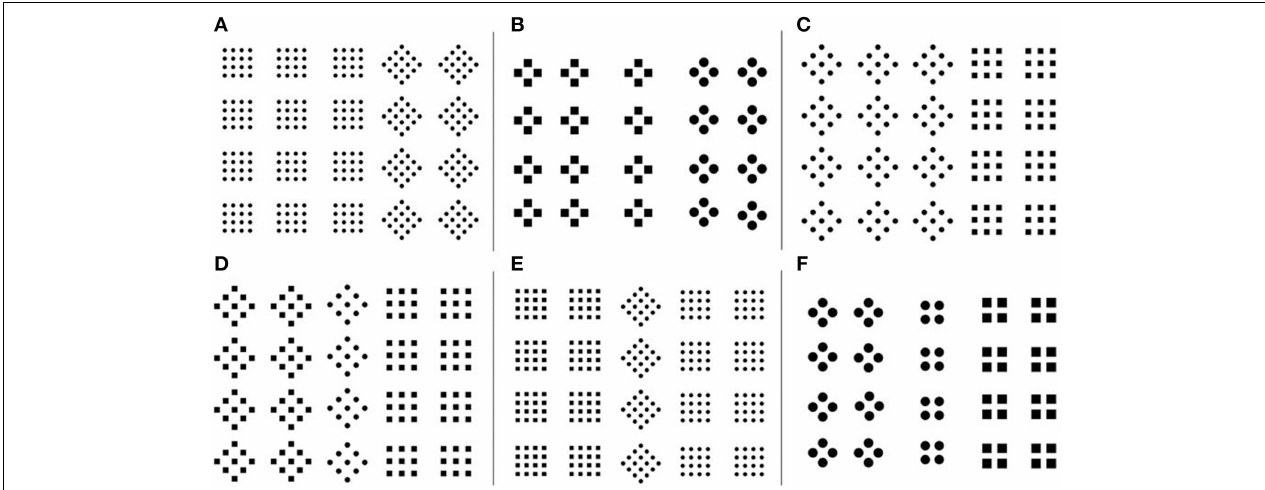
FIGURE 5 | Example trials used in Experiment 2. (A–C) Perfect-match trials for which the answer options differed from each other in configuration only (A) , in element only (B) , or in both (C) ; (D) Configuration-Match trial; (E) Element-Match trial; (F) Conflicting Trial.